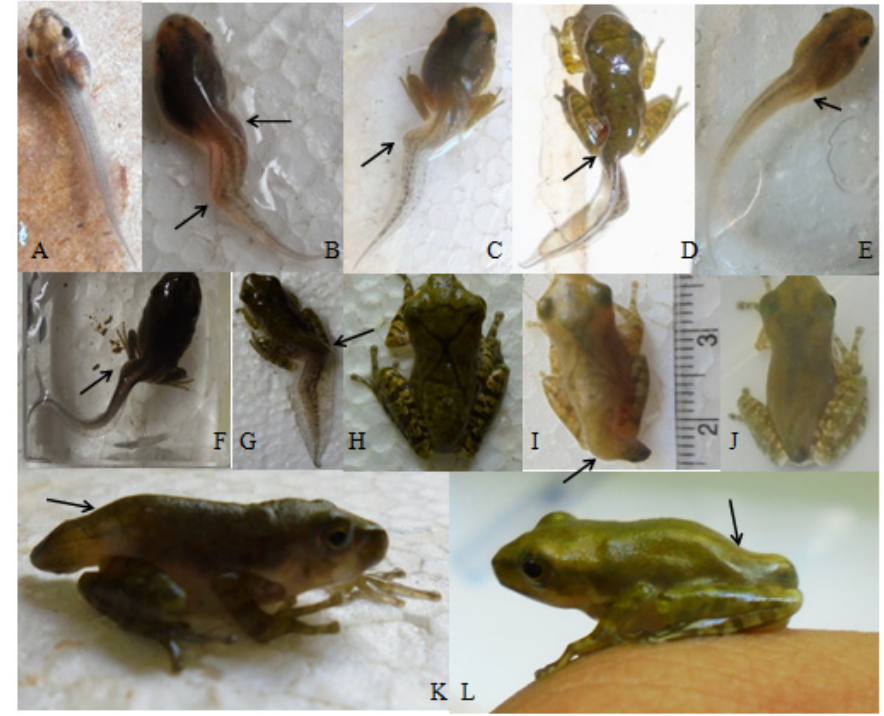
Figure 8: Tadpoles of P. cruciger exposed to cercariae type I at Gosner stage 27/28. A) Uninfected normal tadpole; B to D) infected tadpoles at different developmental stages with scoliosis E to G) kyphosis; H) normal metamorph; I and J) metamorphs with scoliosis (Note the malformation is absent in adult); K and L) metamorphs with kyphosis at 30/31 (A,B,E), 38/39(C,F), 41/42 (D,G),44/45(I,K) Gosner stages, Complete metermorphosis (H, J,